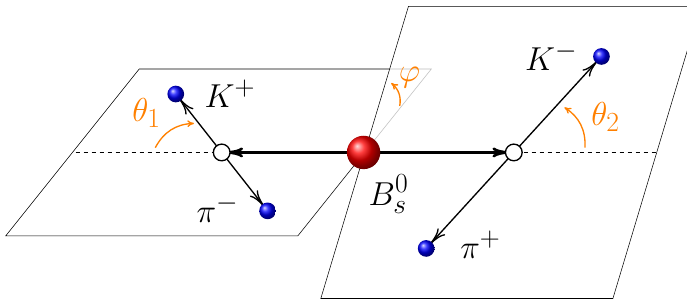
Figure 2 . Graphical de(cid:12)nition of the angles in the helicity basis. Taking the example of a B 0 s ! Q 1 Q 2 decay (this analysis uses B 0 SS , B 0 SV , B 0 V S , B 0 V V , B 0 ST , B 0 TS , s ! s ! s ! s ! s ! s ! B 0 V T , B 0 TV and B 0 TT ), with each (cid:12)nal-state quasi-two-body meson decaying to s ! s ! s ! pseudoscalars ( Q 1 K + (cid:25) (cid:0) and Q 2 K (cid:0) (cid:25) + ), (cid:18) 1 ( (cid:18) 2 ) is de(cid:12)ned as the angle between the directions ! ! of motion of K + ( K (cid:0) ) in the Q 1 ( Q 2 ) rest frame and Q 1 ( Q 2 ) in the B 0 rest frame, and ’ as the s angle between the plane de(cid:12)ned by K + (cid:25) (cid:0) and the plane de(cid:12)ned by K (cid:0) (cid:25) + in the B 0 rest s